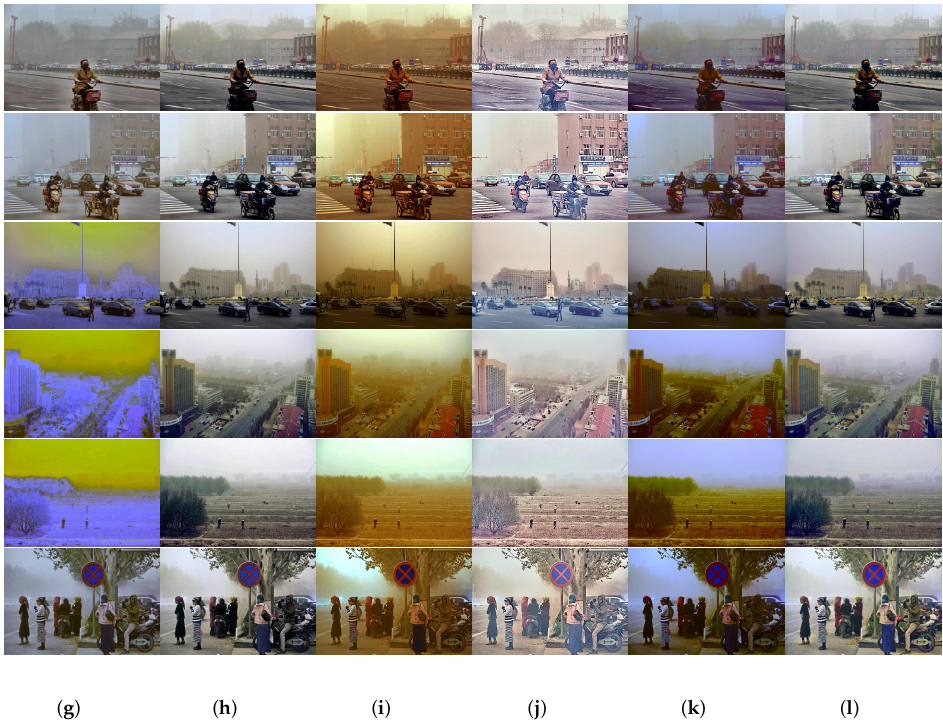
Figure 6. Qualitative comparison results of sand dust images with weak color cast. ( a ) Sanddust Images; ( b ) TFO [9]; ( c ) NGT [11]; ( d ) BCGF [13]; ( e ) AWC [17]; ( f ) VRSI [19]; ( g ) SBT [20]; ( h ) FBE [29];